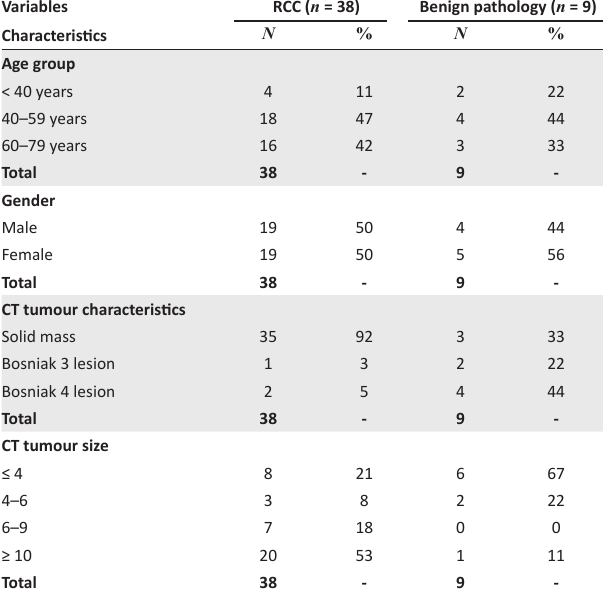
TABLE 2: Comparison of patient and tumour characteristics on imaging in patients with confirmed renal cell carcinoma and those with benign findings on histology (excluding the three patients with non-renal cell carcinoma malignancy).